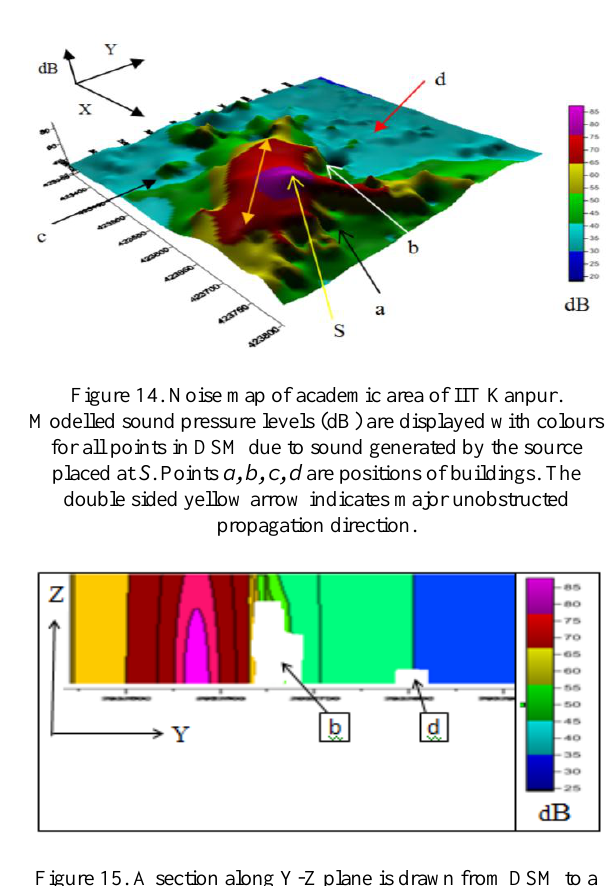
Figure 15. A section along Y-Z plane is drawn from DSM to a height of 20m. Modelled sound pressure levels are displayed with